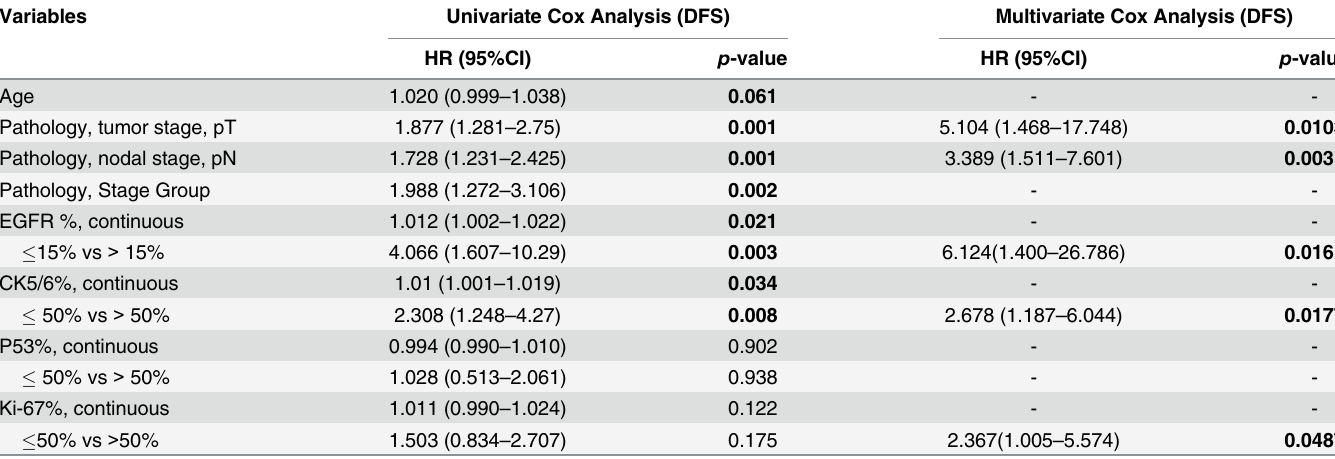
Table 2. Prognostic value of clinicopathological variables in predicting disease free survival using univariate and multivariate Cox